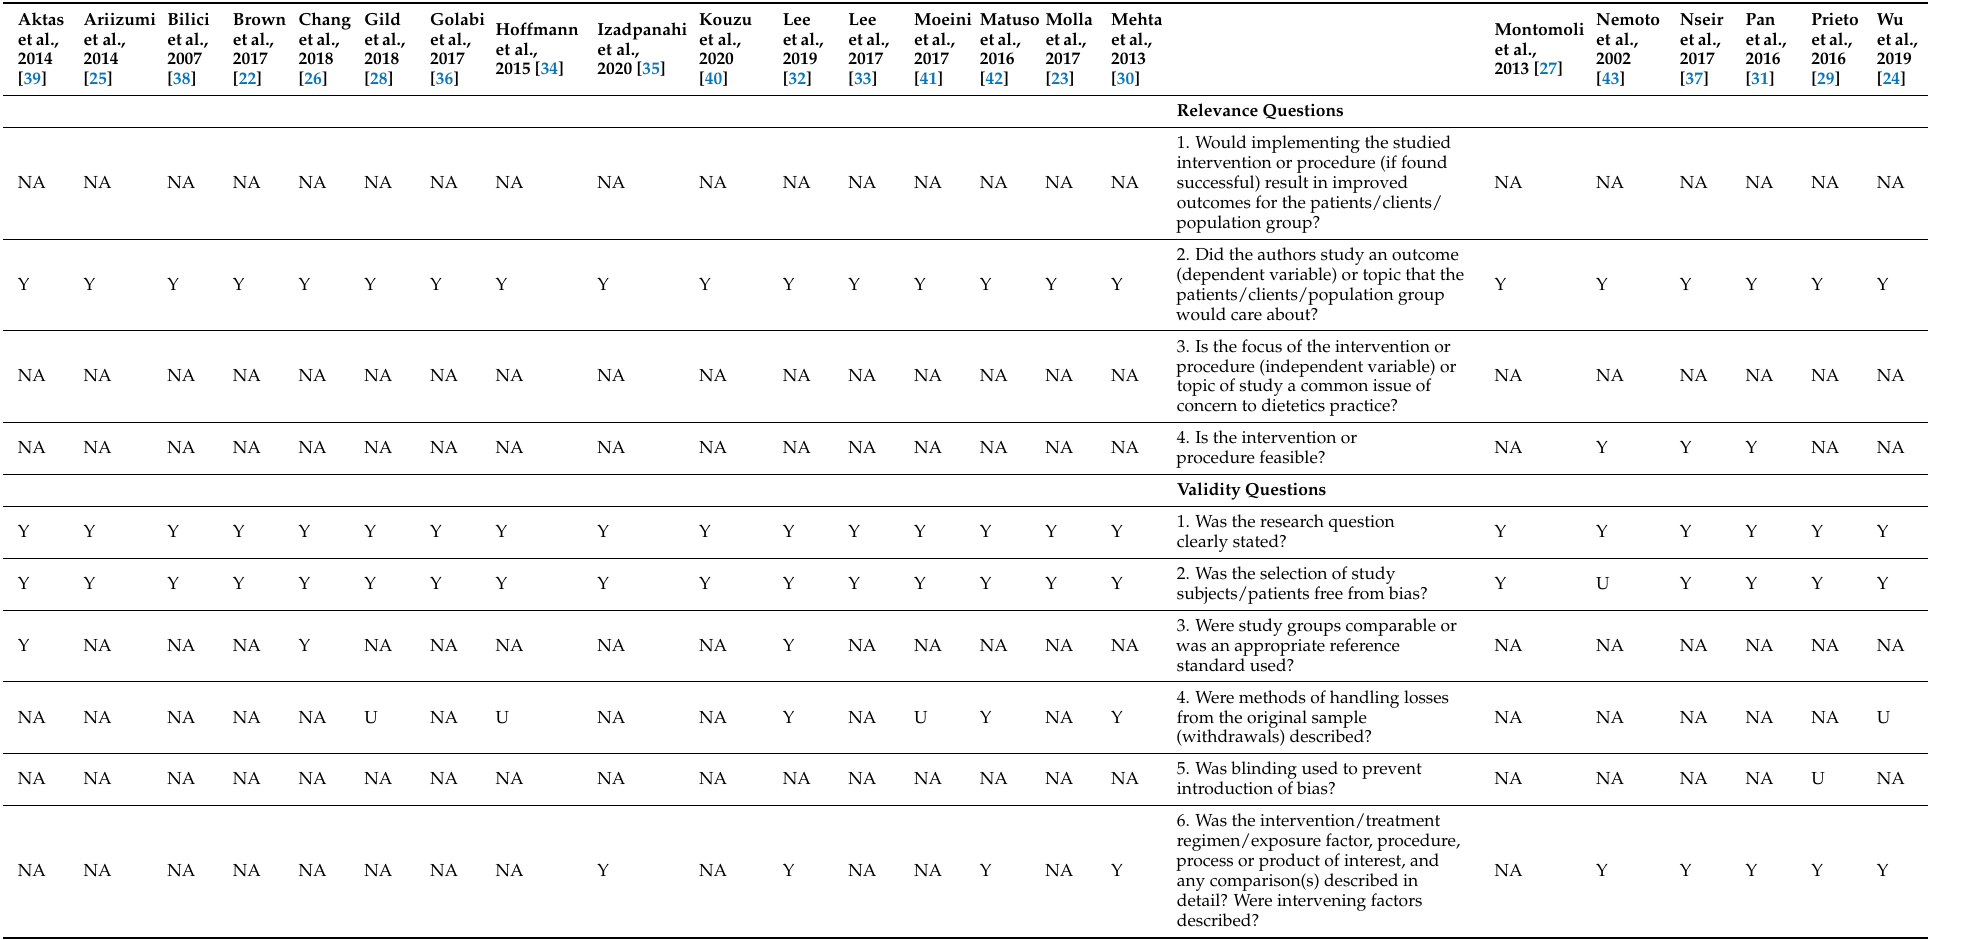
Table 4. Critical appraisal of the 23 studies with the use of Quality Criteria Checklist 1